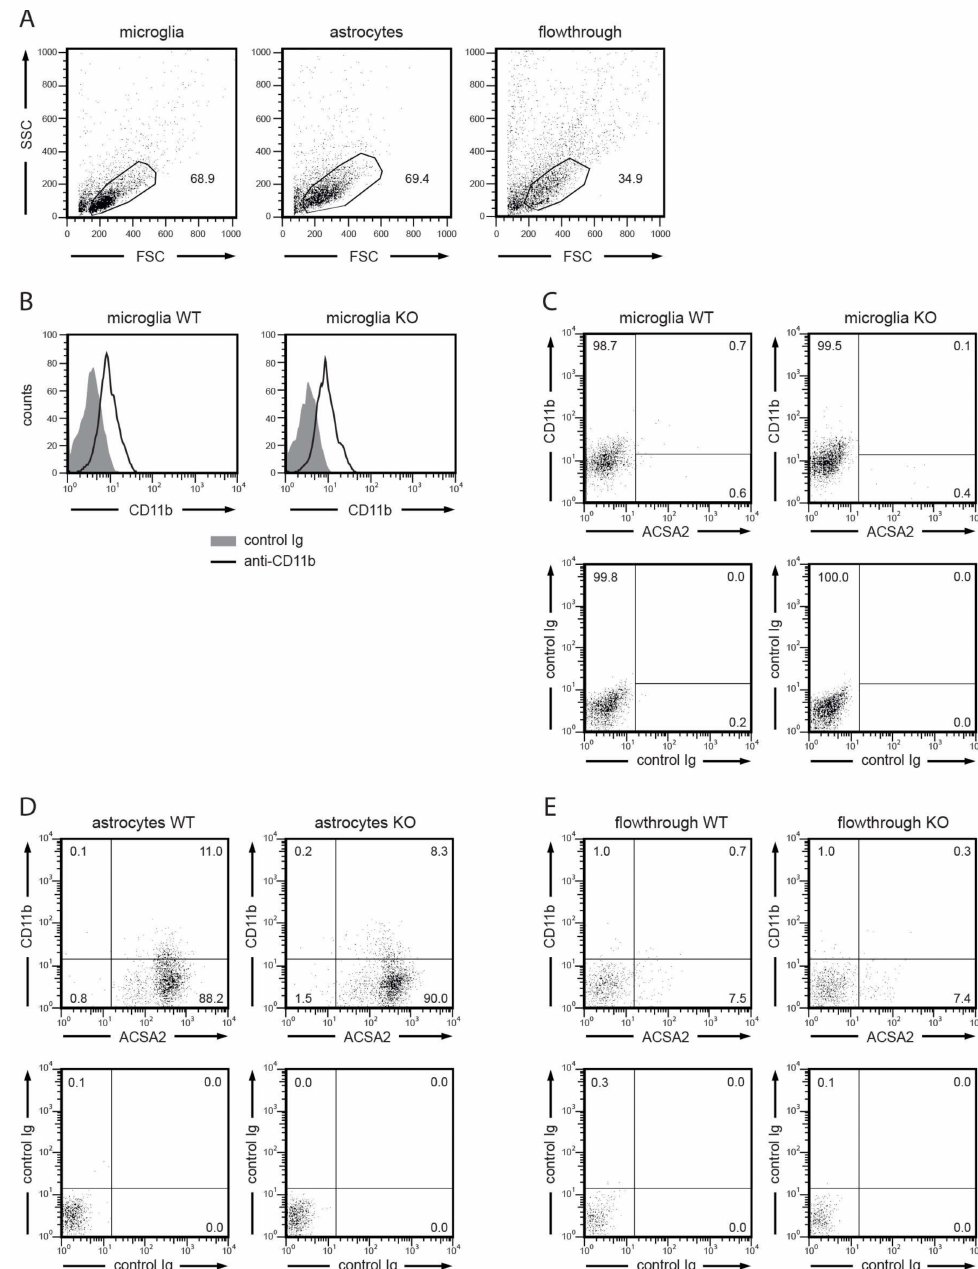
Figure 2. Microglia and astrocyte subsets were isolated from mouse brains, and the purity of the isolates was analyzed by flow cytometry. Gated on viable cells ( A ), the microglia fraction uniformly stained with a FITC-conjugated mAb for CD11b ( B , C ) though not with the astrocyte marker ACSA2 ( C ). CD11b staining intensity was low since the cells had been preincubated with a nonlabelled anti-CD11b mAb as part of the purification protocol. Conversely, the astrocyte ( D ) and flowthrough ( E ) fractions were mostly ACSA2 + CD11b − (with some cells dimly expressing CD11b) or ACSA2 − CD11b − , respectively. Staining with irrelevant control antibodies is shown for